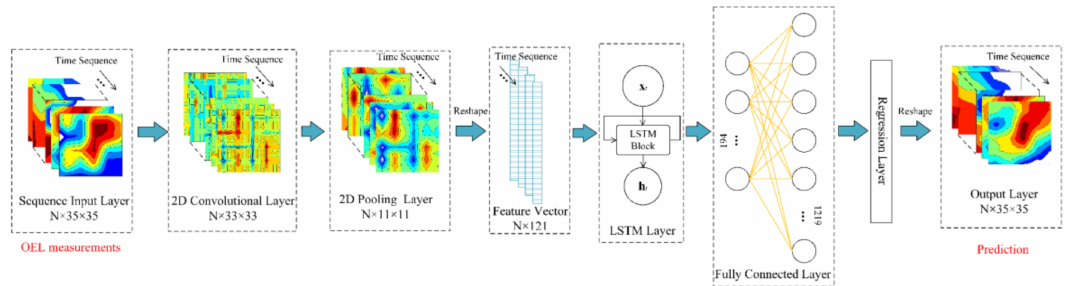
Figure 5. The architecture of deep learning network for the rainfall field nowcasting: the sequence input layer receives oblique earth-space link (OEL) measurements, the convolutional- and pooling layer extract the spatial feature of rainfall field, the Long Short-Term Memory (LSTM) layer learns the time-dependence of spatial feature vectors and fully connected layer as well as regression layer predicts the regional rainfall for the next